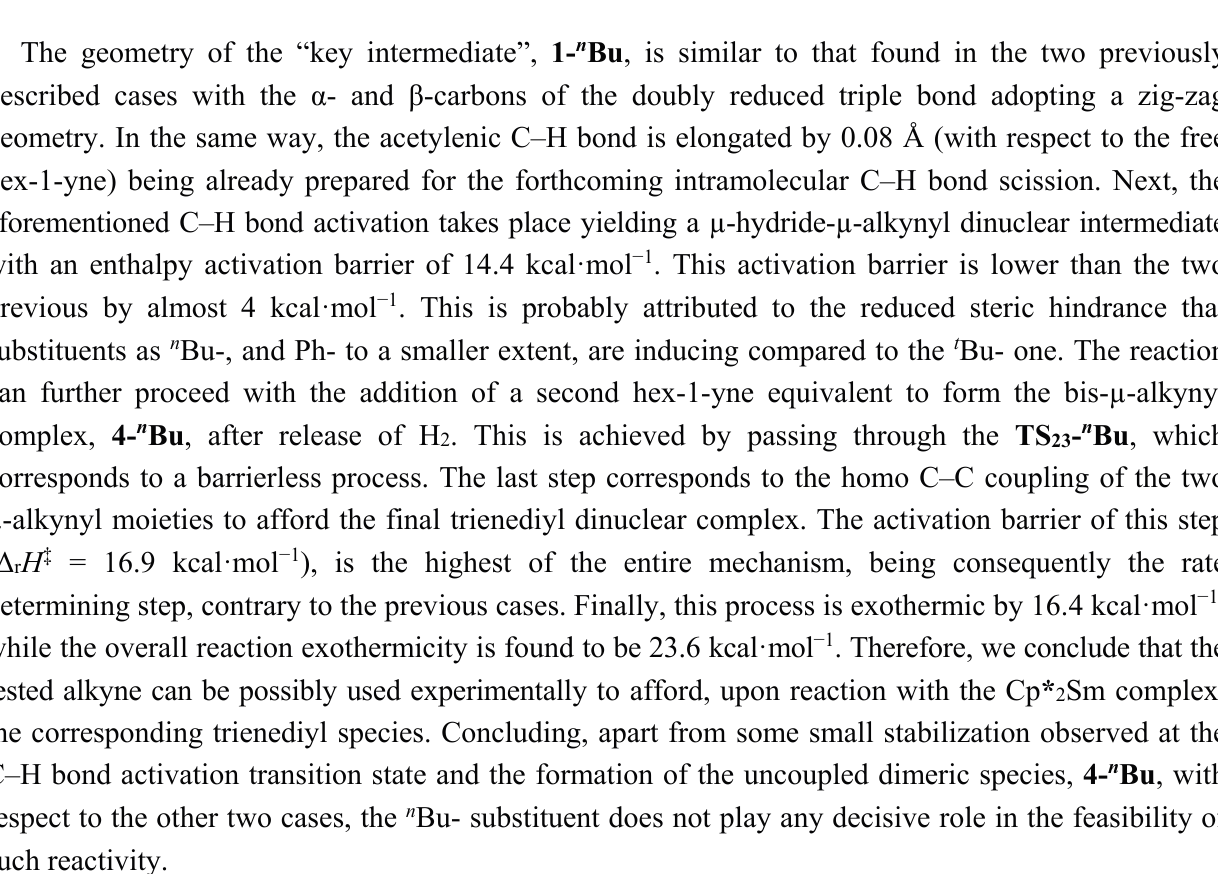
Figure 8. Enthalpy energy Δ H (kcal·mol − 1 ) profile for the formation of the trienediyl complex using n BuC ≡ CH as substrate and (Cp * ) 2 Sm as a precursor. Cp * ligands are omitted for clarity. Numbers in blue correspond to natural